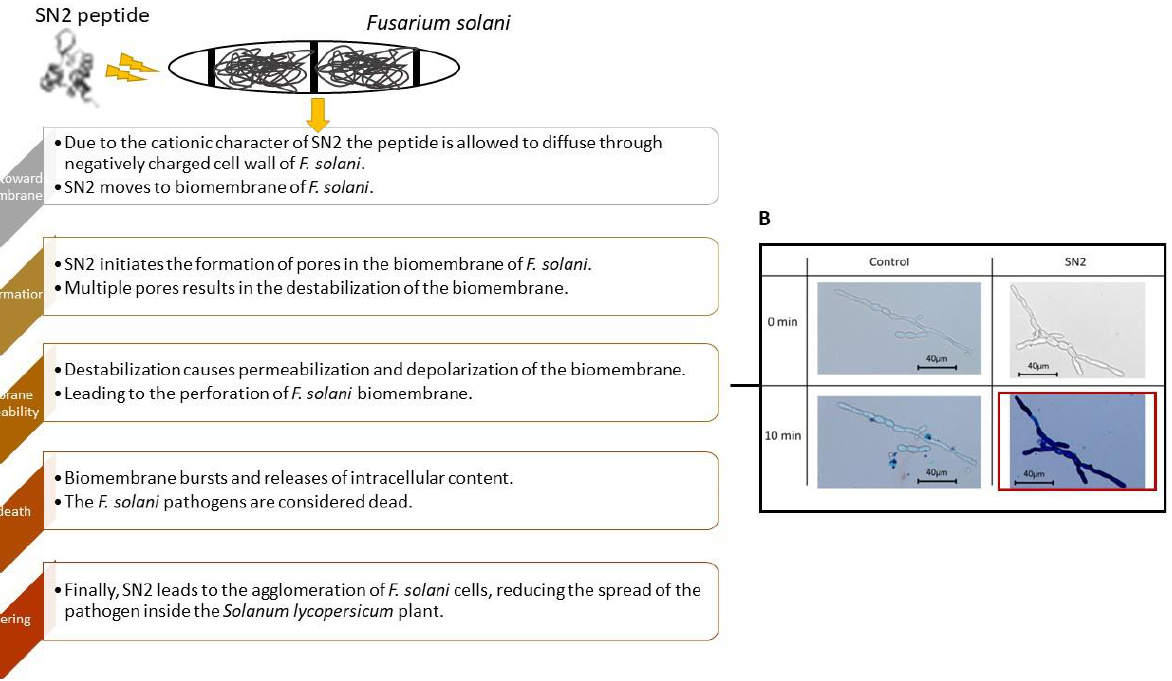
Figure 2. Schematic diagram of the mode of action of SN2 peptide on Fusarium solani pathogen. ( A ) The cationic SN2 peptide has a high affinity for the negatively charged cell wall of F. solani , diffusing through the cell wall to initiate pore formation on the biomembrane. This ultimately results in the rupture of the biomembrane, releasing the intracellular contents of the pathogenic cell, killing the F. solani pathogen [71,72]. ( B ) Cell viability assay conducted on F. solani pathogen treated with SN2 peptide. Trypan Blue dye (0.5%) was used to test the cell viability by infiltrating pathogenic cells with damaged biomembranes and staining these cells. This microscopic image represents that after 10 min of exposing F solani to the SN2 peptide, most of the SN2-treated cells were stained blue compared with the control, indicating SN2 disrupted the biomembrane allowing the dye to penetrate the SN2-treated cells, killing the pathogenic cells